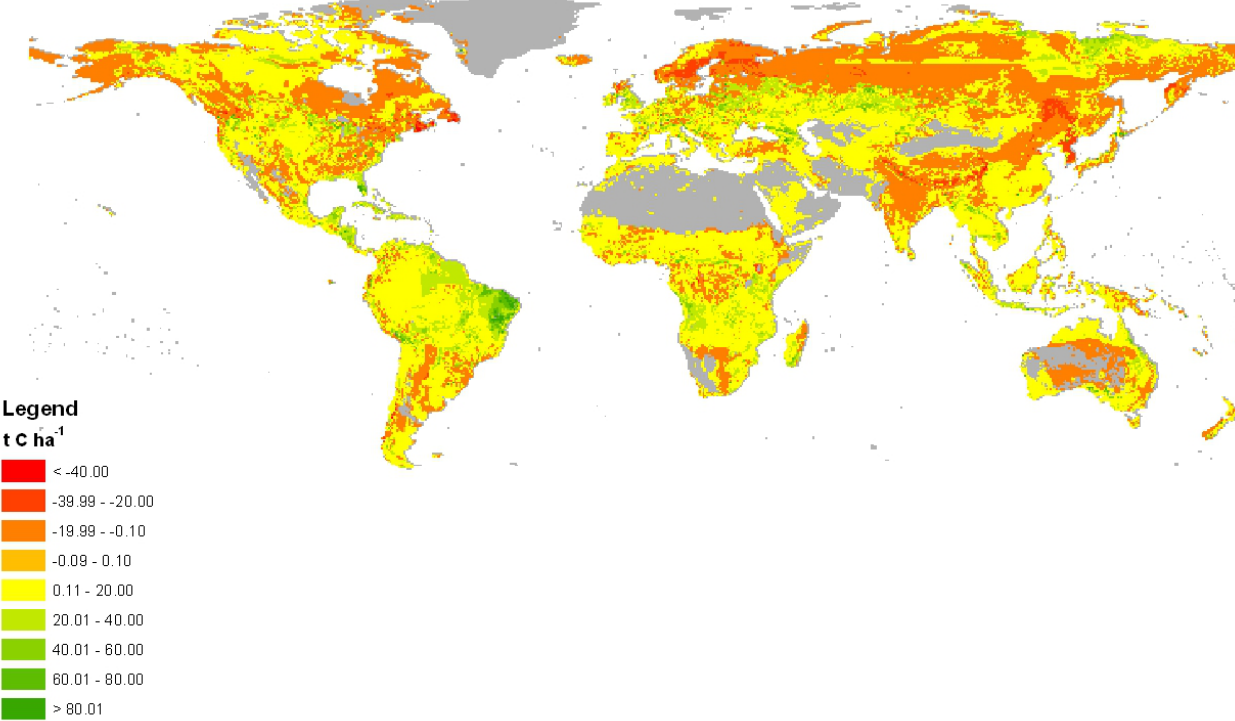
Fig. 7. Average trend in SOC concentration of all 10 scenarios from 1971 to